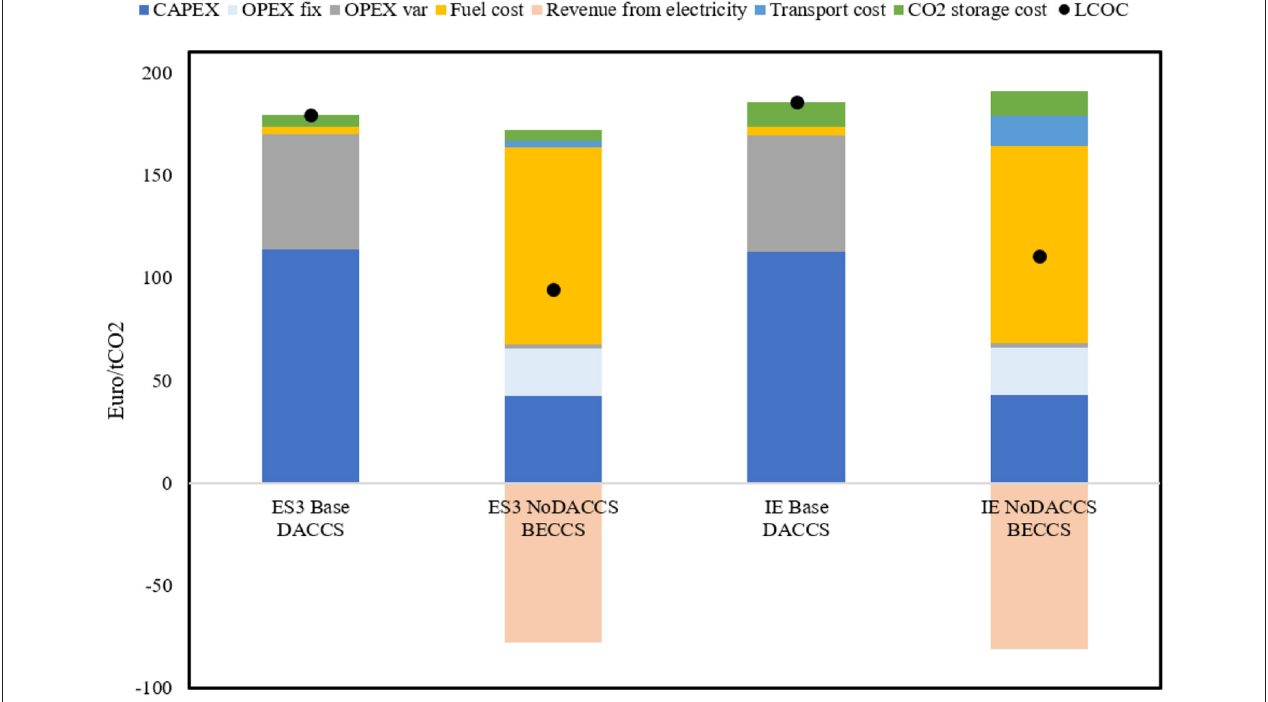
FIGURE 4 | LCOC calculated for DACCS and BECCS in regions ES3 (sunny) and IE (windy) for the Base case and the NoDACCS case respectively.